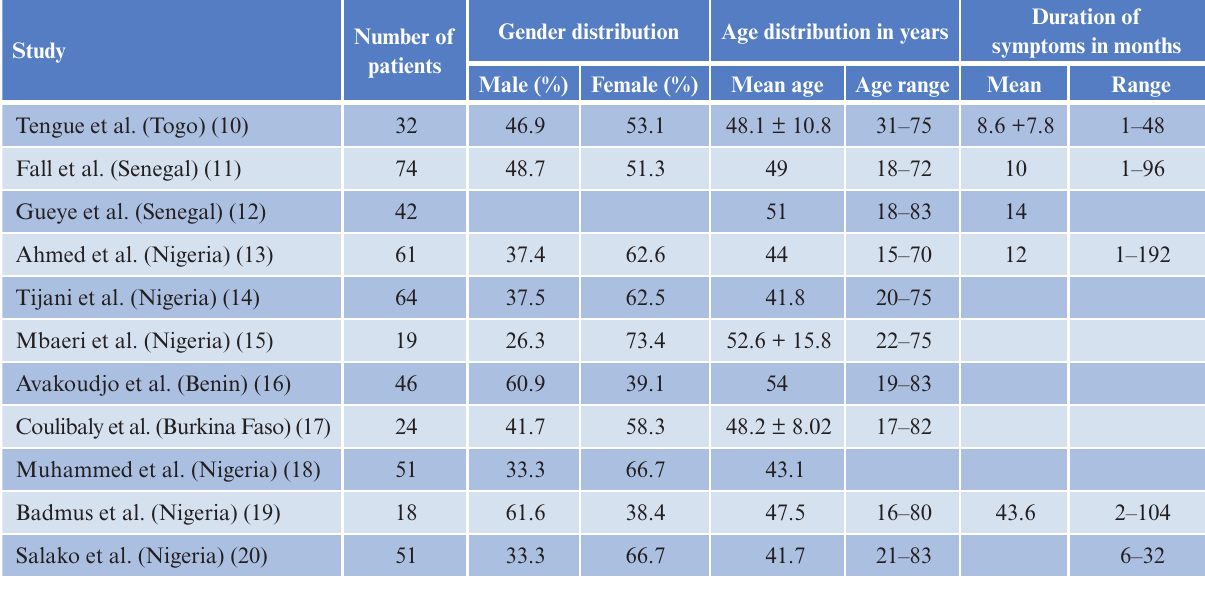
Table 1: Demographics, age distribution, and duration of symptoms in patients with renal cell carcinoma Number of Study